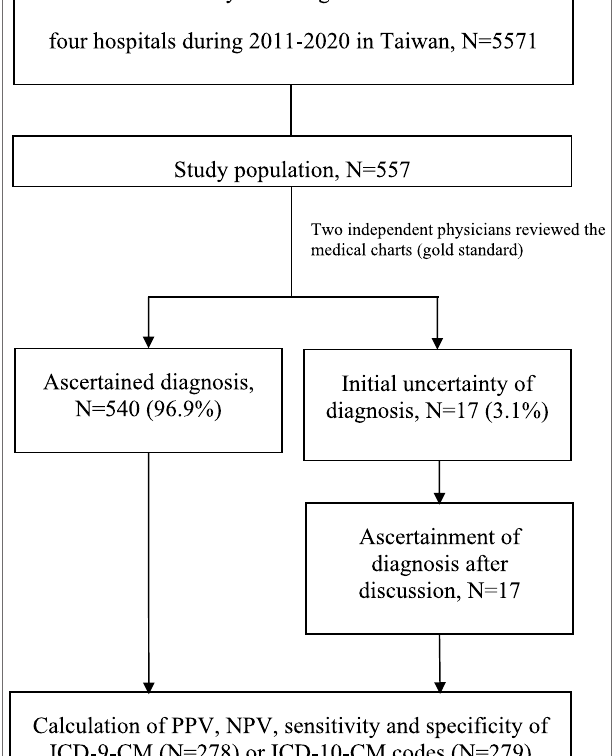
FIGURE 1 | Process of case